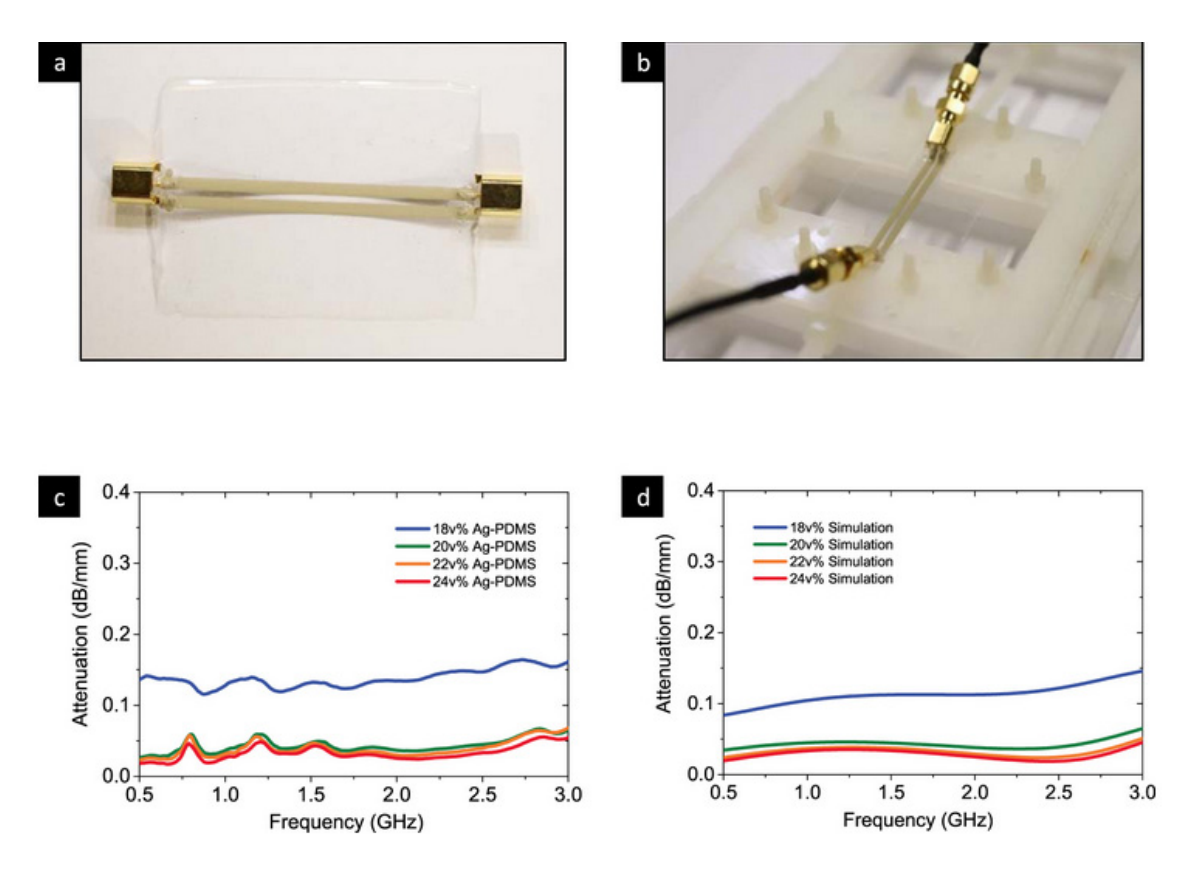
Figure 11. The Ag-PDMS sample with transmission line adapters seen in ( a ), ( b ) the tensile test fixture ( c ) graphing the different Ag volumes in comparison to the attenuation of transmission line, and ( d ) showing the attenuation of the transmission [148].